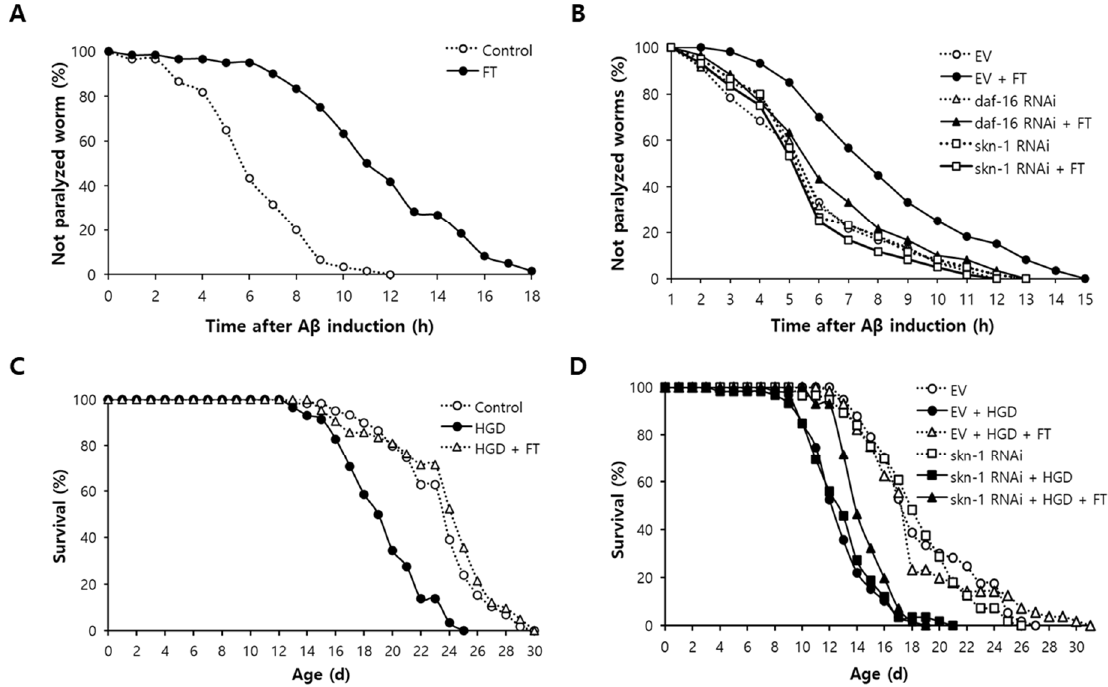
Figure 3. Amelioration of A β - and HGD-induced toxicity by fisetin. ( A ) The percentage of paralyzed worms by A β -induced toxicity was monitored every hour after A β induction in muscle tissues ( n = 60). ( B ) Effect of daf-16 or skn-1 knockdown on inhibitory activity of fisetin against A β -induced paralysis was measured using RNAi. ( C ) Survival curves of animals were compared among untreated control, HGD-treated group, and HGD and fistein-treated group to evaluate the effect of fisetin on DM ( n = 60). ( D ) Role of fisetin on HGD-induced toxicity was examined in worms fed with EV or skn-1 RNAi clone. Statistical analysis of survival curves was performed usig the log-rank test. A β , amyloid beta; FT, 0.1 g/L of fisetin; EV, empty vector; RNAi, RNA interference; HGD, high-glucose